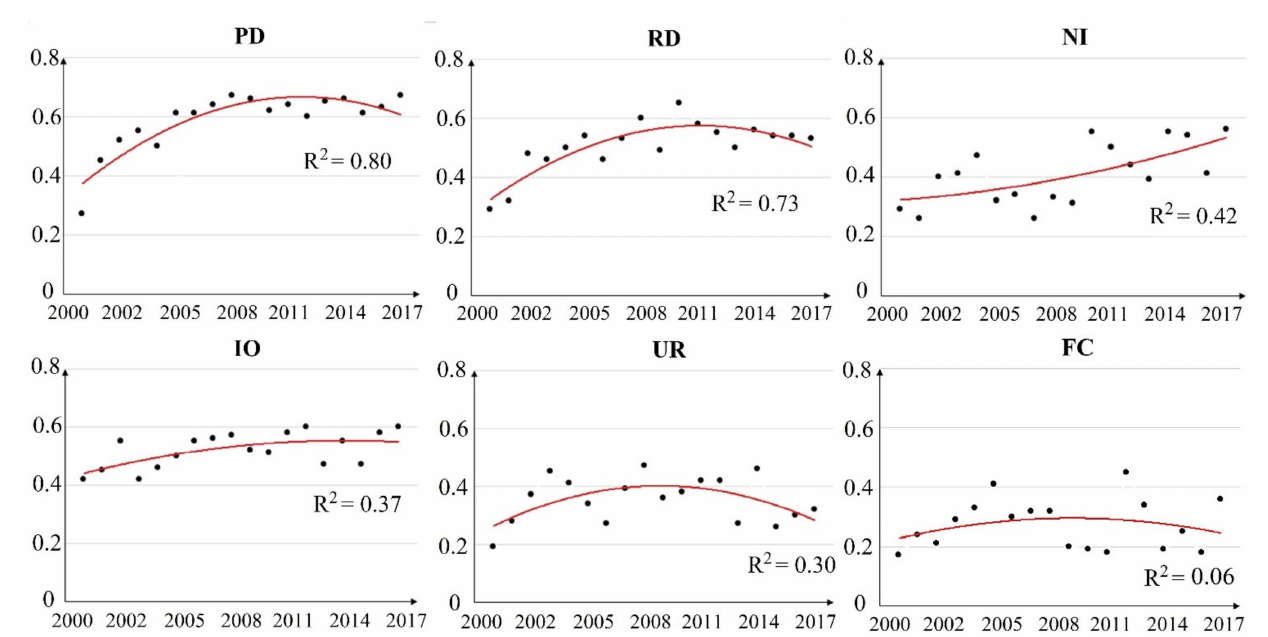
Figure 6. Scatter plots with trend lines of q values for each impact factor from 2000–2017.